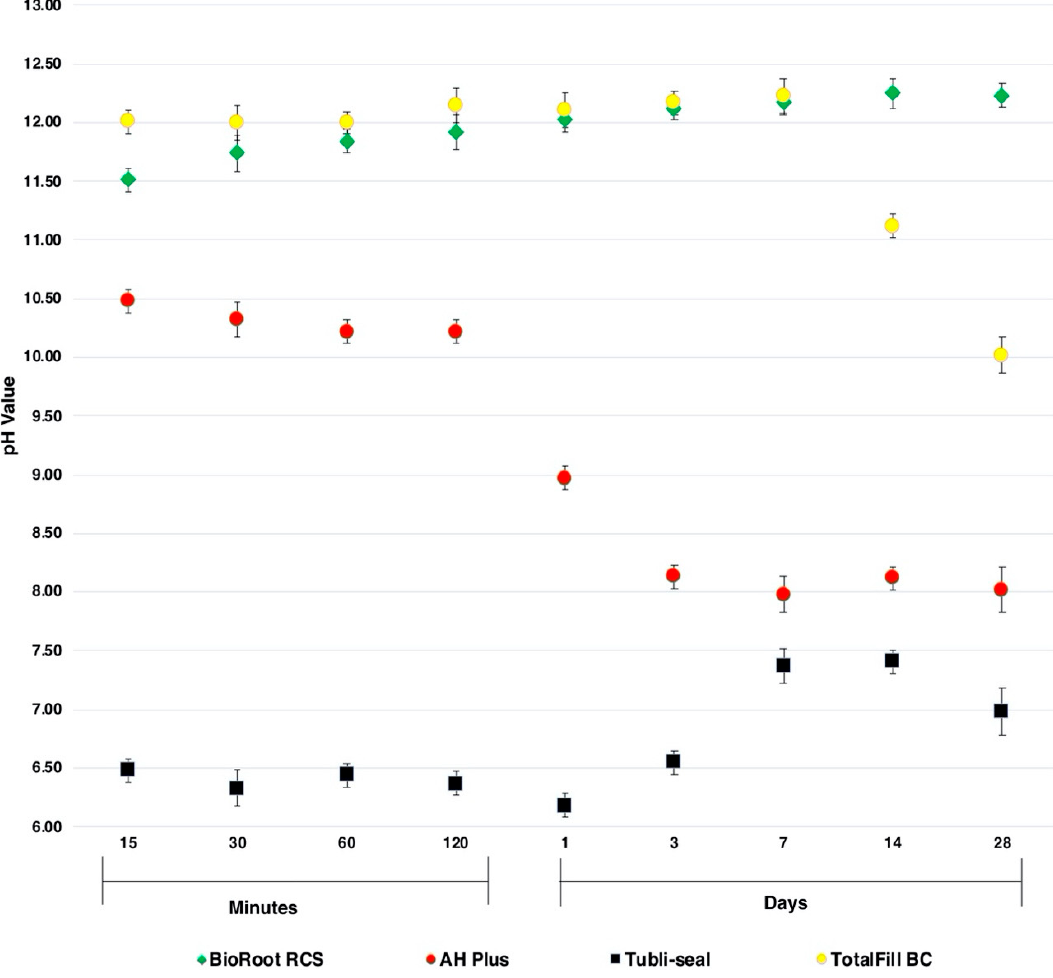
Figure 4. The pH values of the endodontic sealers. The results represented the mean ( ± standard error) of pH values tested after 15, 30, 60, 120 min and 1, 3, 7, 14, 28 days.